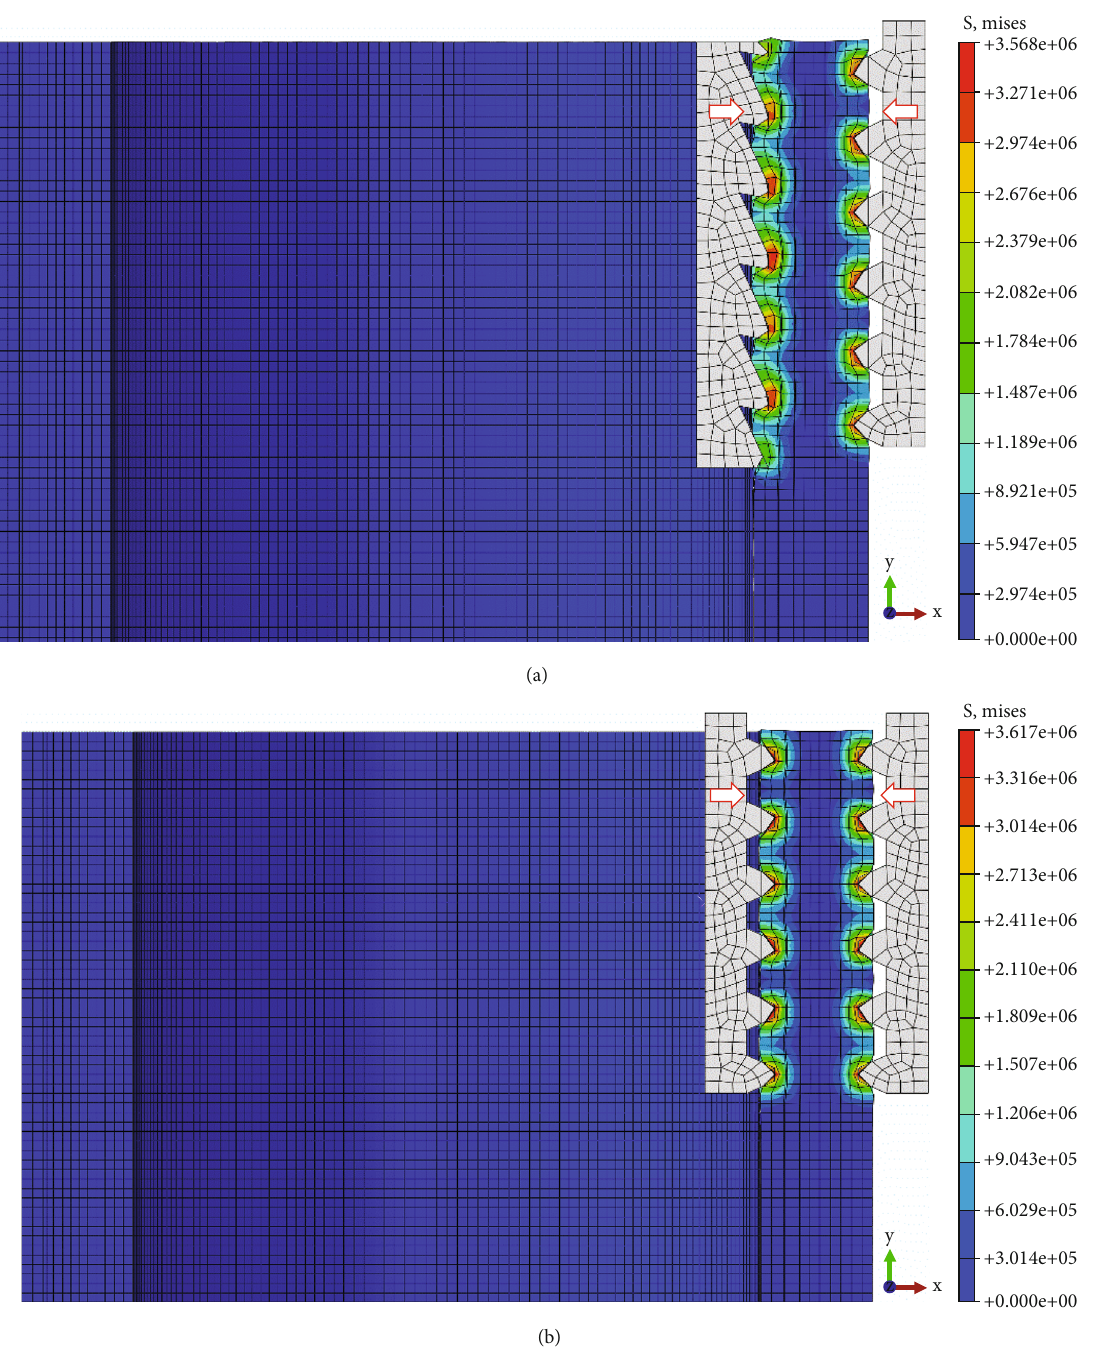
Figure 6: Resulting Mises stress in the crimping process for (a) bionic and (b) traditional crimping